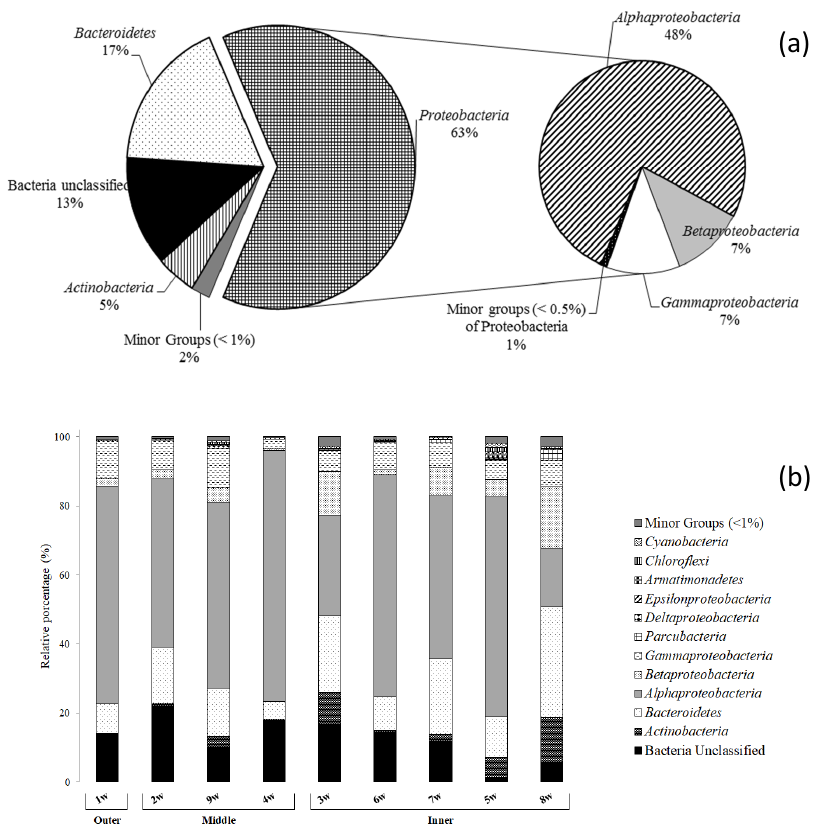
Figure 3. Phylogenetic groups retrieved in ( a ) all water samples and ( b ) at each sampling site along the Pasvik River.